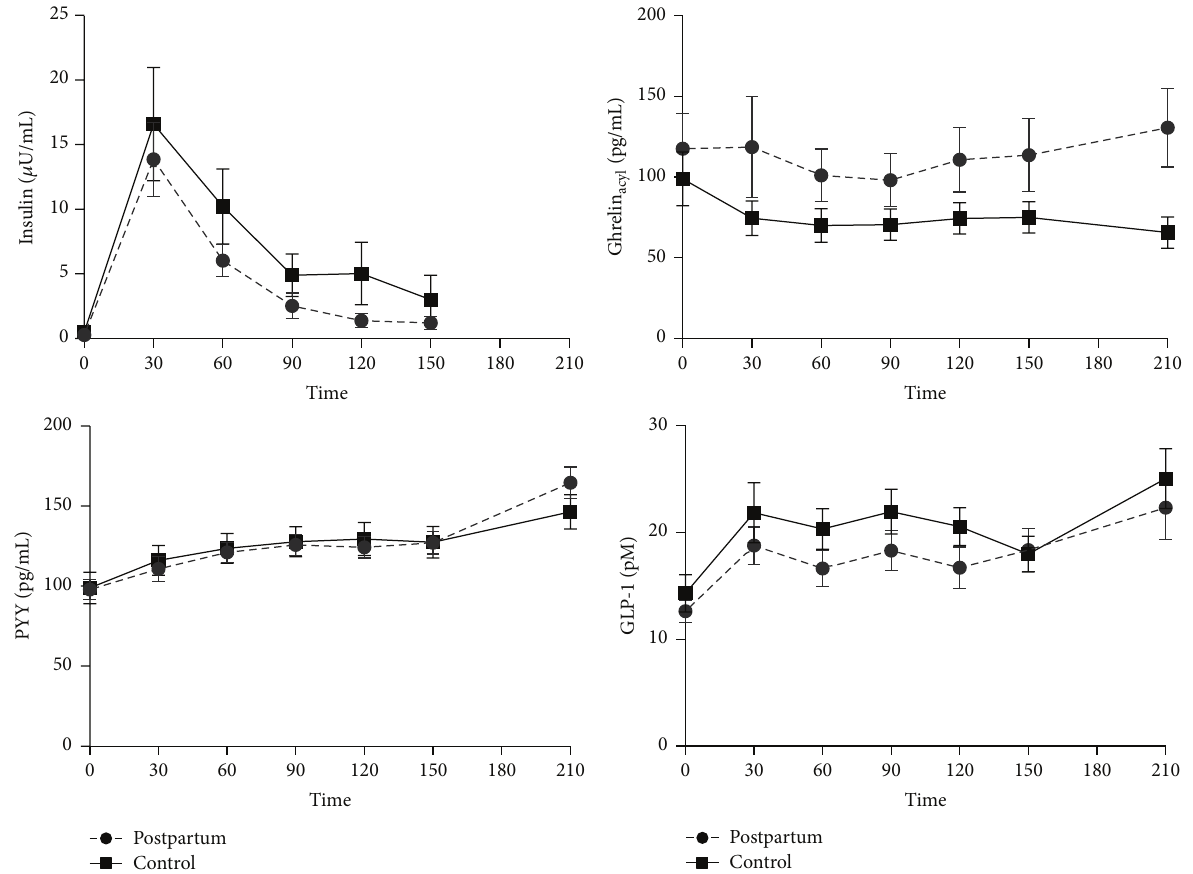
Figure 2: Fasting (time 0) and meal-induced responses of insulin, acylated ghrelin, PYY, and GLP-1 to a standardized breakfast meal in 24 postpartum lactating women (circles, dashed lines) and 20 never-pregnant controls (squares, solid lines).